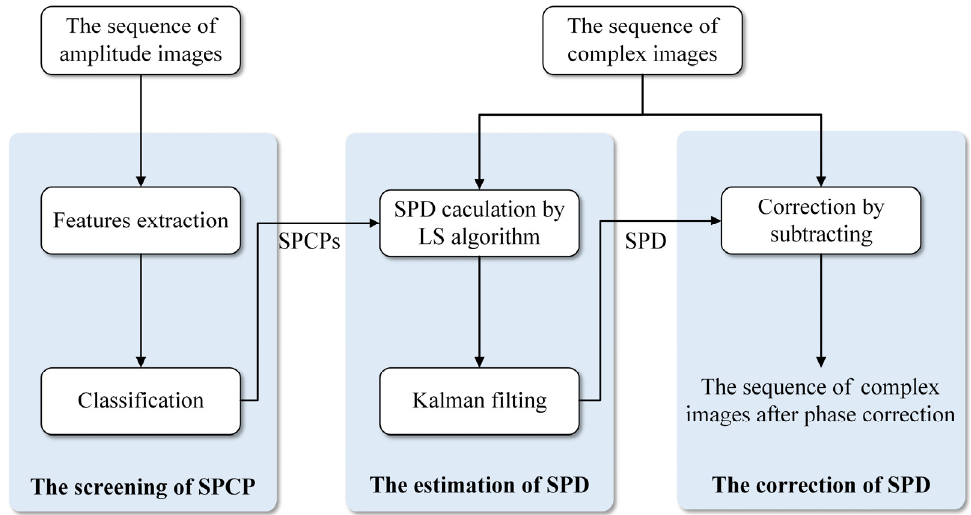
Figure 6. The complete process flow of the correction approach.